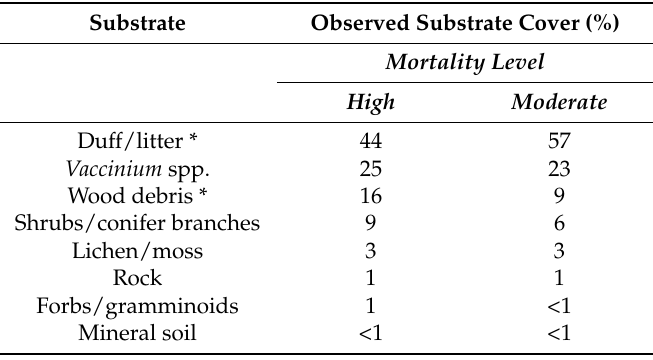
Table 1. Forest floor substrate for high and moderate mortality